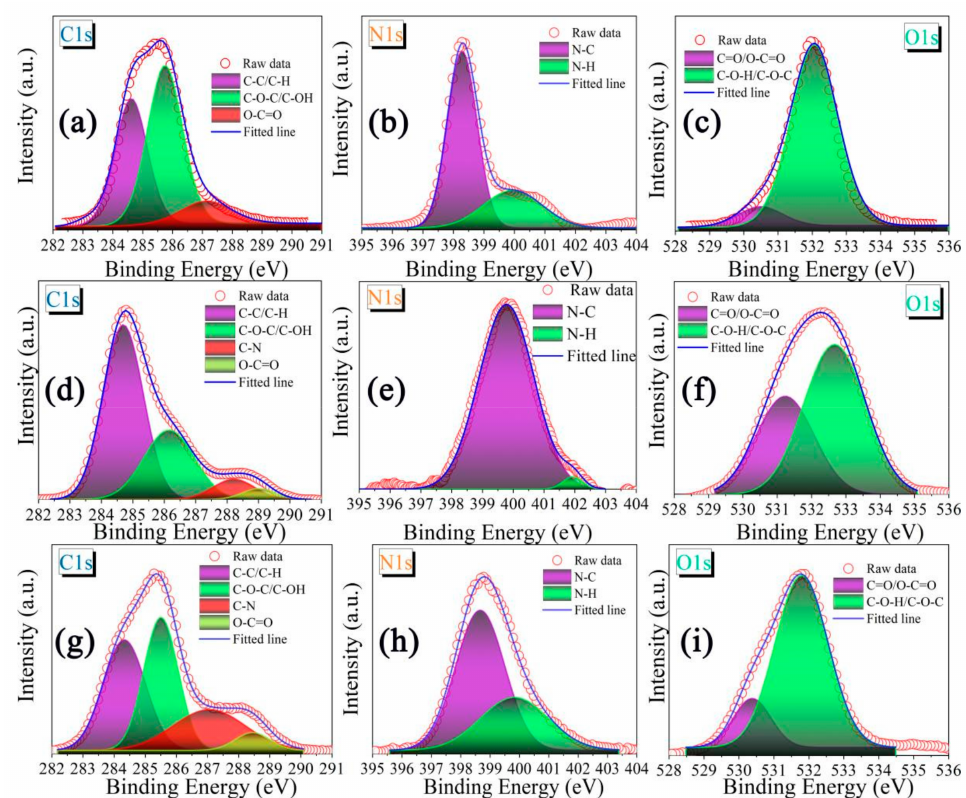
Figure 3. The high-resolution C1s, N1s, and O1s XPS spectra of ( a – c ) p-CNDs, ( d – f ) n-CNDs, and ( g – i ) CNDs aerogel.